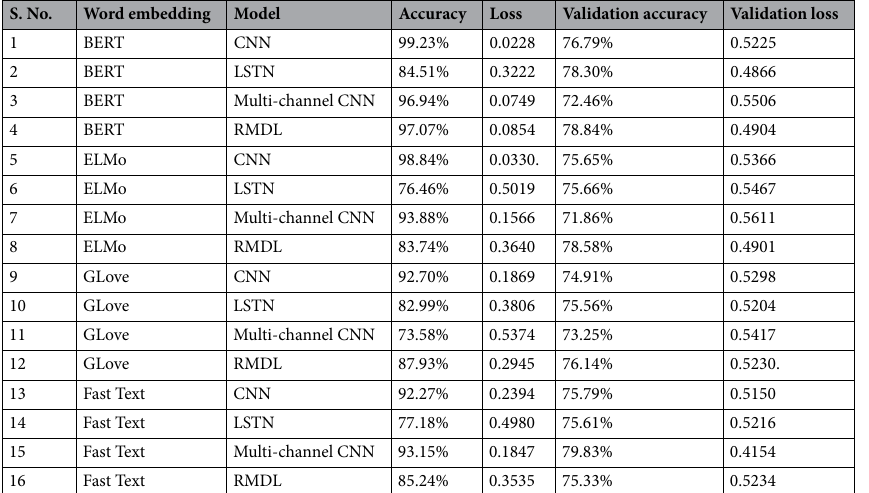
Table 4. Various Aspects of the analysed